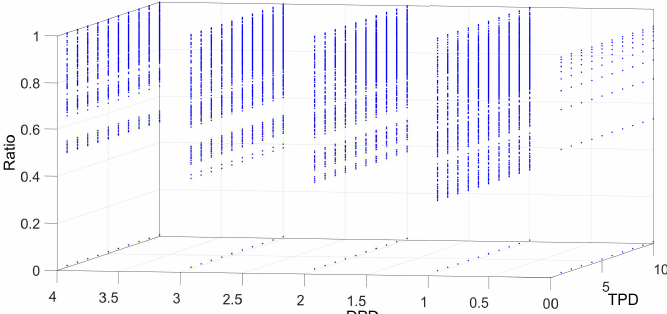
Figure 9. Relationship between the decrement potential level (DPD) and the threshold (TPD) in Dlayer . No direct relationship in event reduction among these values is found.